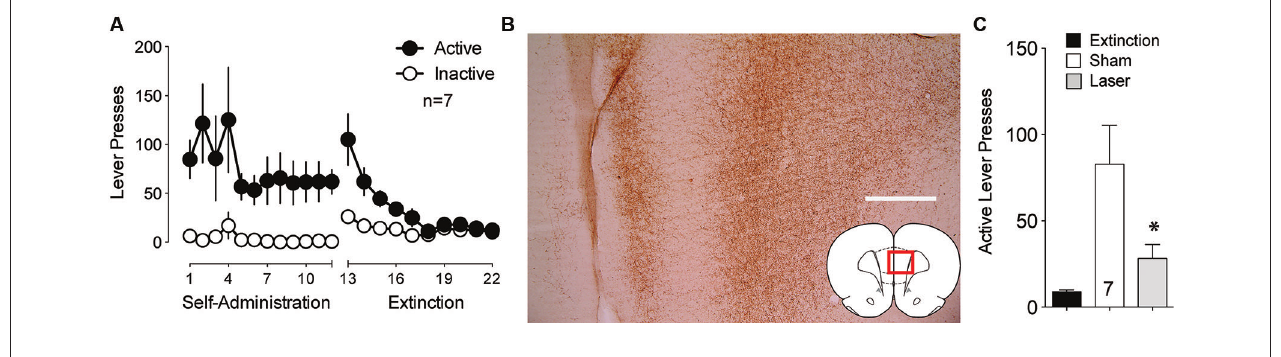
FIGURE 3 | Optical inhibition of BLA-to-PL fibers blocks cue-primed reinstatement. (A) Active lever pressing during self-administration and extinction training ( n = 7). (B) ArchT-expressing fibers in the PL after virus injection in the BLA. Scale bar, 300 µ m. (C) Inactivation of ArchT-expressing fibers in the PL significantly